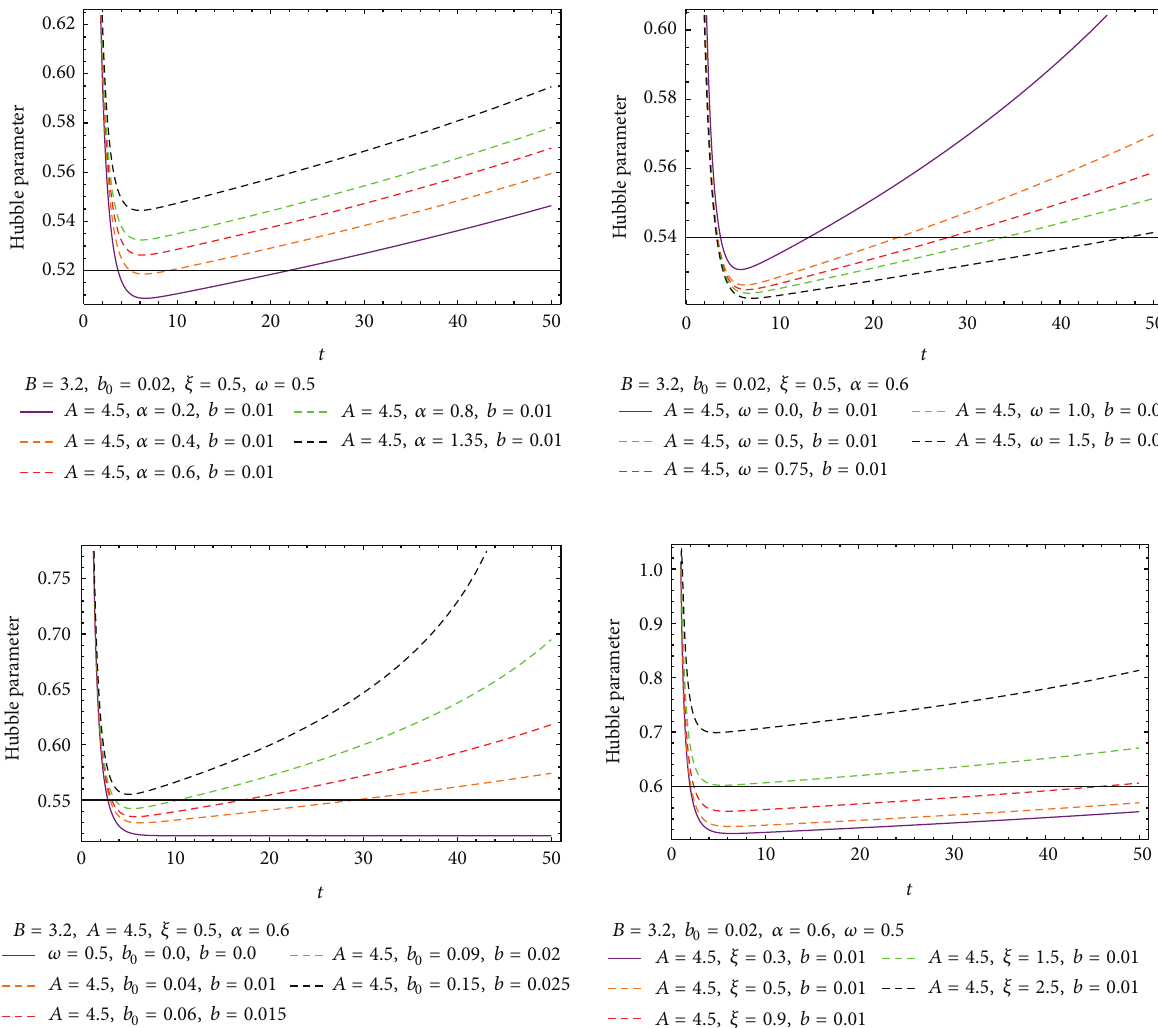
Figure 1: Behavior of Hubble parameter 𝐻 against 𝑡 for interacting barotropic fluid and viscous modified Chaplygin gas.